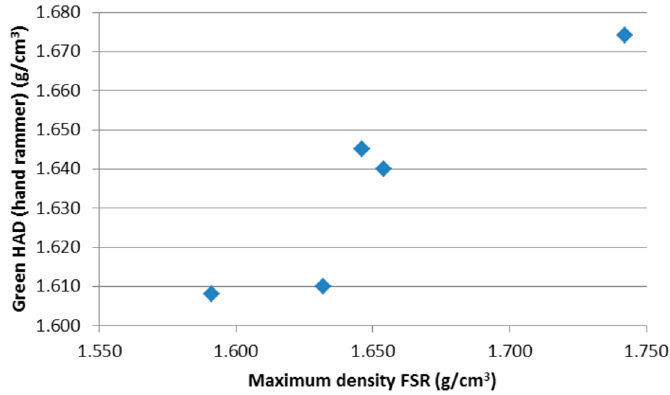
Figure 2. Relation between maximum density given by the Fischer Sand Rammer (FSR) and the apparent green density given by the hand rammer.